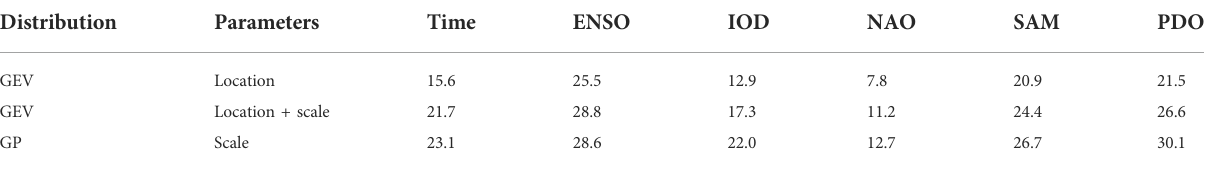
TABLE 1Percentage(%)of stations showing statistically signi fi cant improvementswith the inclusionof covariates compared toconsistent stationary models.